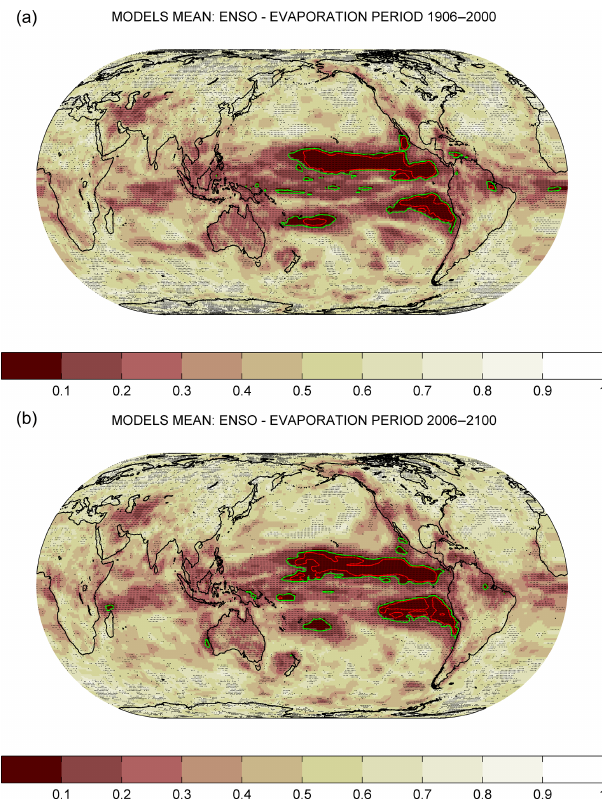
Figure 1. Multi-model mean probability map for the absence of Granger causality between ENSO and annual mean evaporation for the periods 1906–2000 (a) and 2006–2100 (b) . Stippling demon- strates that at least 70% of models show agreement on the mean probability of all models at a given grid point. An individual model’s agreement is determined when the difference between the multi-model mean probability and the selected model’s probabil- ity is less than 1 standard deviation of multi-model mean probabil- ity. The green (red) contour line designates a p value of 0.1 (0.05). Brown shades indicate low probability for the absence of Granger causality. ENSO: El Niño–Southern